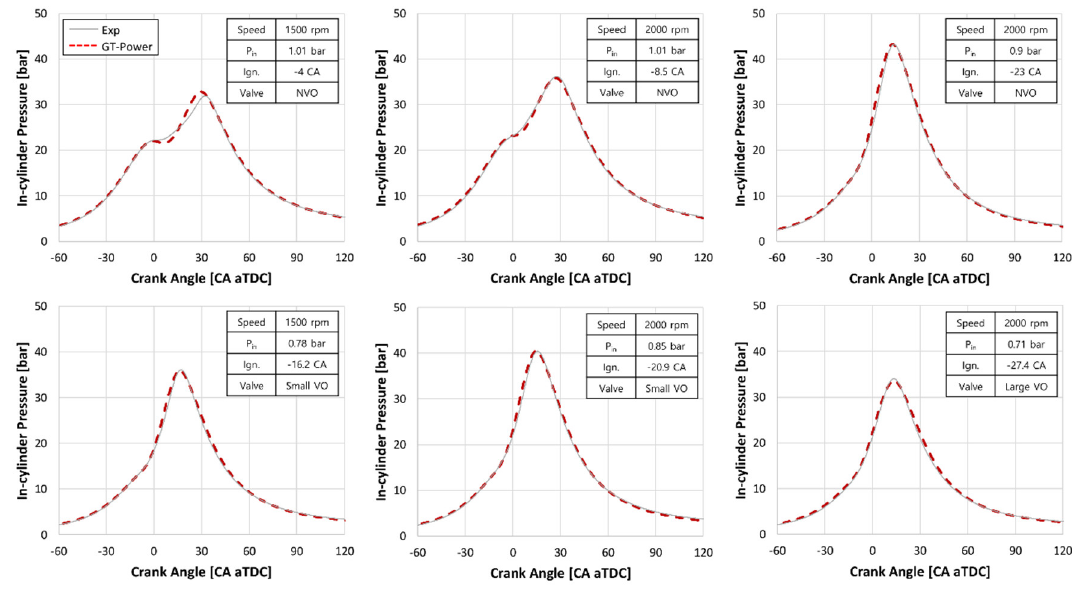
Figure 10. 1D simulation results in various firing conditions. Table 4. Multipliers for optimization